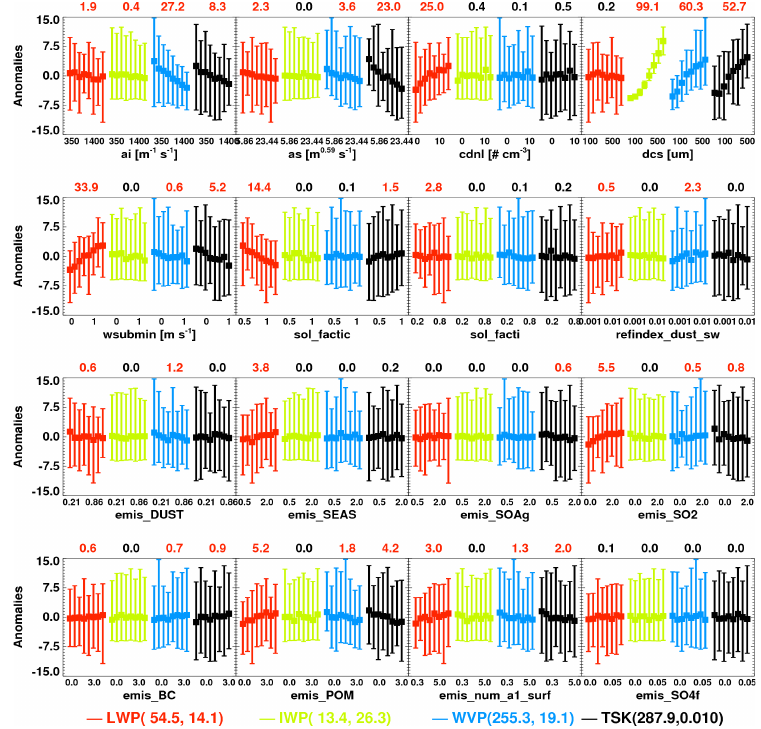
Fig. 4. Same as Fig. 1, but for anomalies of variation of global mean liquid water path (LWP), ice water path (IWP), water vapor path (WVP), and surface temperature (TSK) in response to the perturbations of 16 parameters from the 256 CAM5 simulations. The units for anomalies of LWP, IWP, WVP, and TSK are g/m 2 , g/m 2 , hg/m 2 , and K/50, respectively.